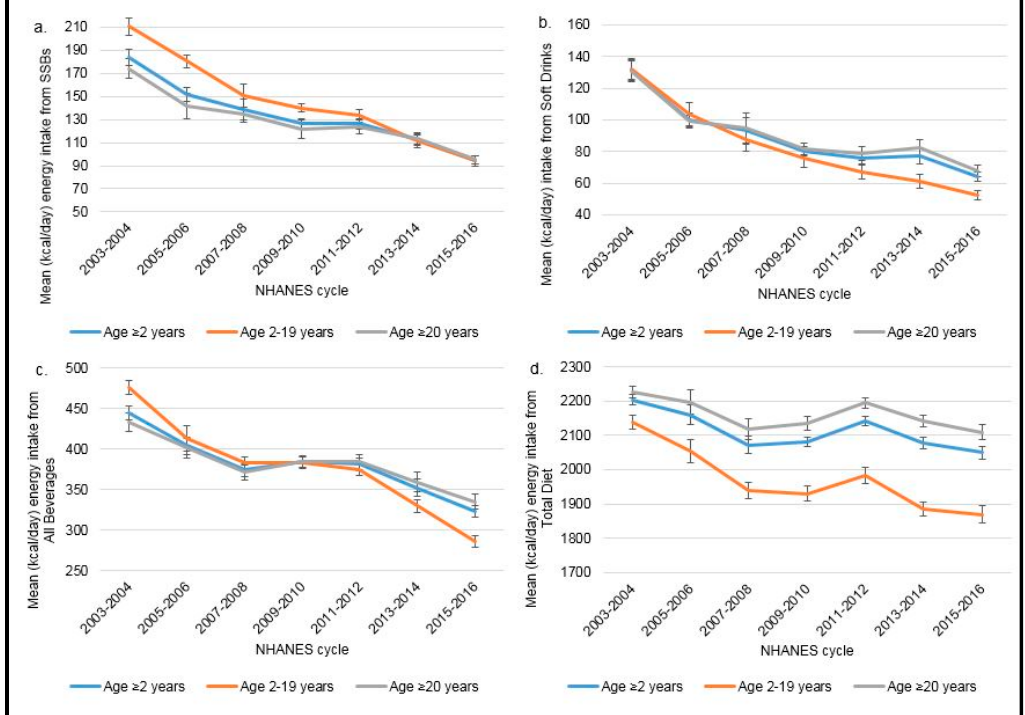
Figure 1. Trends in energy intake from ( a ) sugar-sweetened beverages (SSBs); ( b ) soft drinks; ( c ) all beverages; and ( d ) total diet in the US by age group.